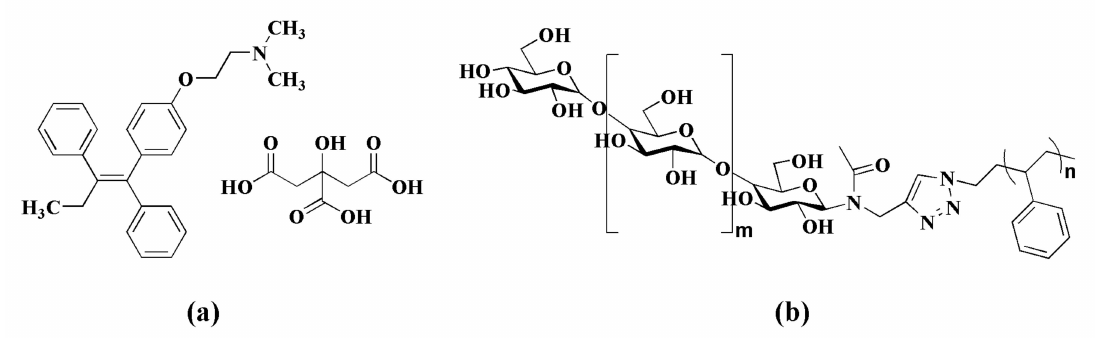
Figure 1. Chemical structures of ( a ) tamoxifen citrate and ( b ) maltoheptaose- b -polystyrene